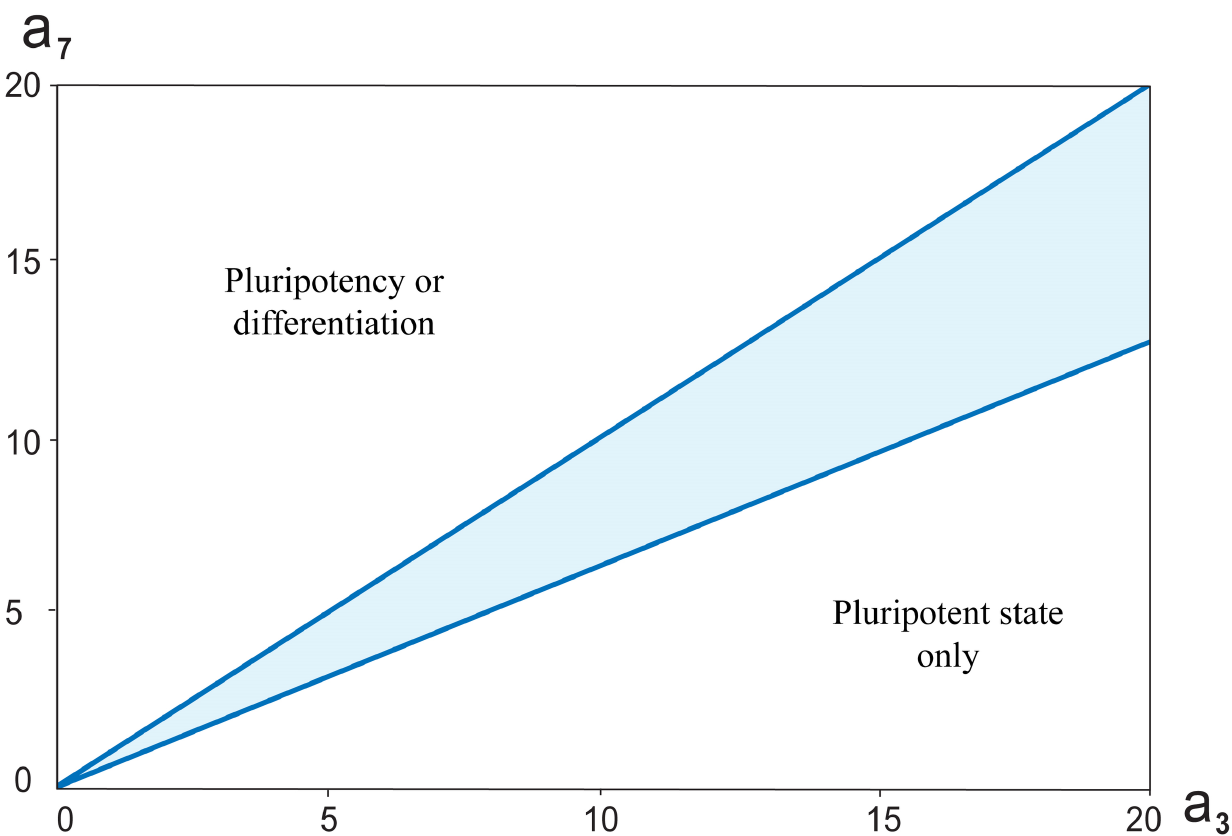
Fig 8. The bistable switch in the core network depending on ( a , a ) parameters and at h = 6 . Highlighted region is the parameters range, for which 3 7 the switch-like behavior has existed. Furthermore, the analysis indicated that a straight line a 3 = a 7 in the plane ( a 3 , a 7 ) divides it into two areas. When a 3 < a , there will be some A , that upon A > A the cell is pluripotent, while at A < A the cell will differentiate. When a 7 0 0 0 all values A (cid:21) 0